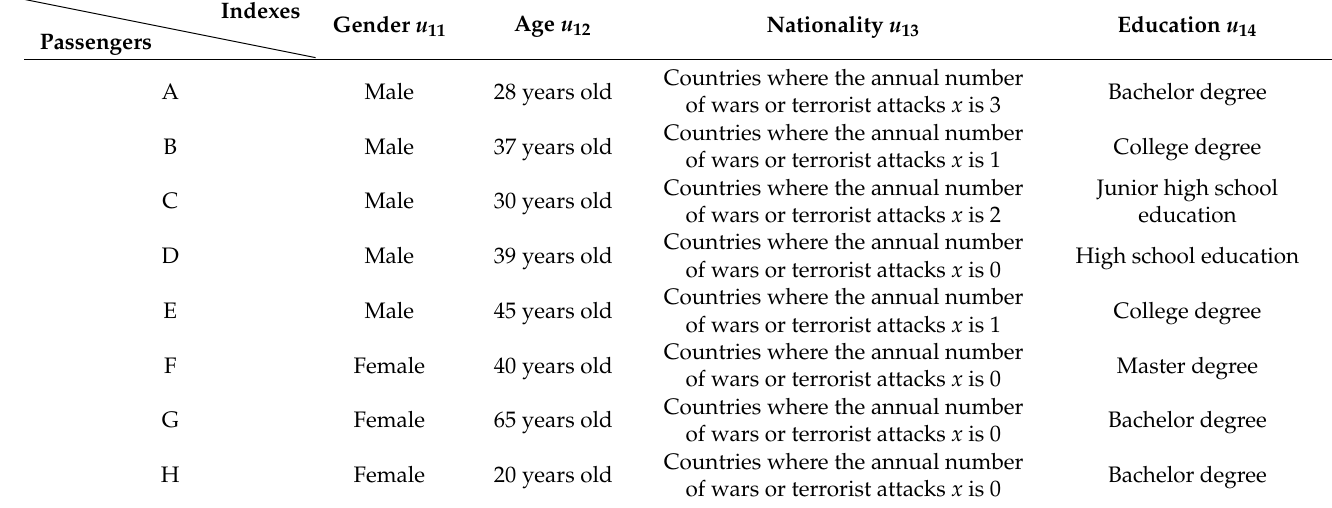
Table 14. Sample data of passengers (basic background indexes).